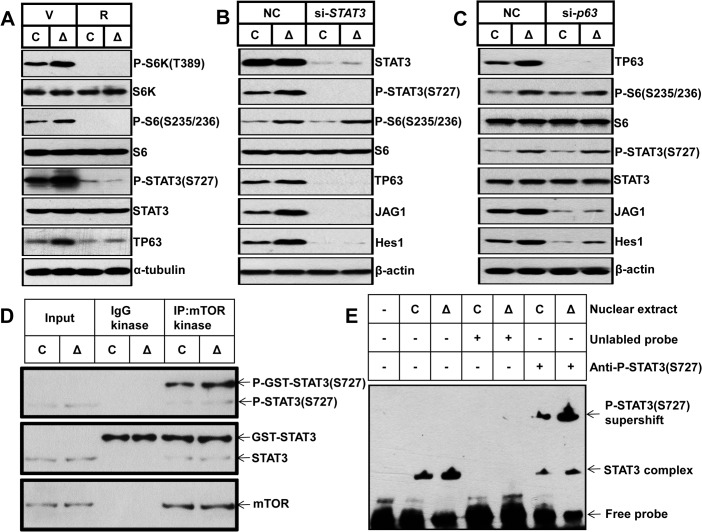
mTORC1 impairs osteoblast differentiation through the STAT3/p63/Jagged/Notch cascade upstream of Runx2.(A) Control and ΔTsc1 primary calvarial cells were treated with vehicle (V) or 0.1 nM rapamycin (R) for 24 hours and then underwent immunoblotting to detect phosphorylation of STAT3 (Ser727) and TP63 (total p63). Control and ΔTsc1 primary calvarial cells were treated with STAT3 (B) and p63 (C) siRNA and negative control (NC) for 48 hours and then underwent immunoblotting to detect mTORC1 activity, phosphorylation of STAT3(Ser727), TP63 (total p63) and activity of Notch pathway (JAG1, Hes1). (D) Cultured primary calvarial cells were immunoprecipitated with anti-mTOR antibody and the precipitated mTOR was assayed for kinase activity against recombinant GST-tagged full-length STAT3. (E) Nuclear extract from control and ΔTsc1 primary calvarial cells were analyzed using EMSA. Binding of STAT3 to biotin-labeled DNA probes is shown as “STAT3 complex”. To compete with the binding, an unlabeled STAT3 binding site DNA probe was added to the reaction in 200 times molar excess. Adding anti-pSTAT3 (S727) antibody to the reactions caused reduction of STAT3-DNA binding and bands of supershift.